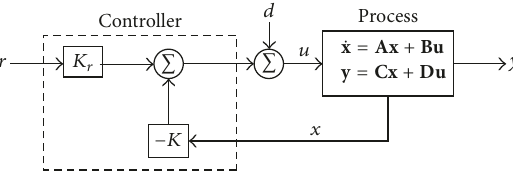
Figure 14: Block diagram of a system with state feedback ( 𝐾 ) and input 𝐾 𝑟